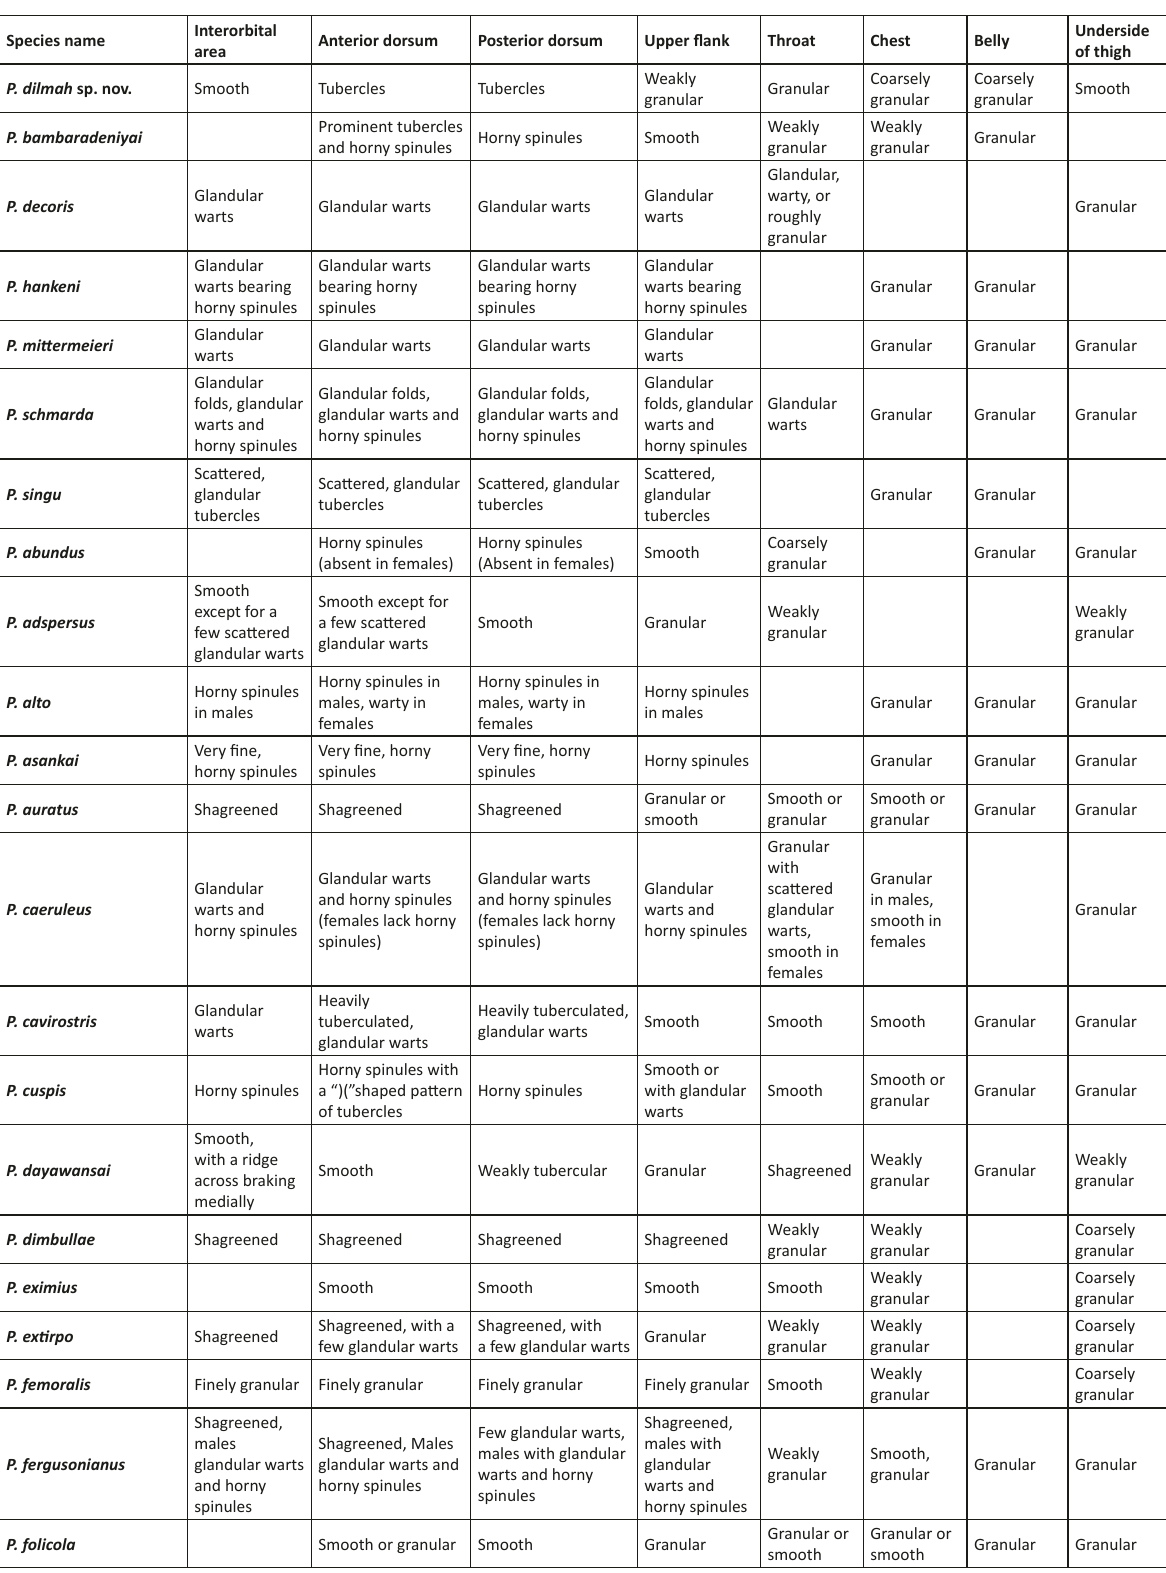
Table 3. Characters in the skin structure that differentiate Pseudophilautus dilmah sp. nov., among congeners of the genus Pseudophilautus. An empty cell in the table denotes either the same character as that of the new species, or for few extinct species when there was no data